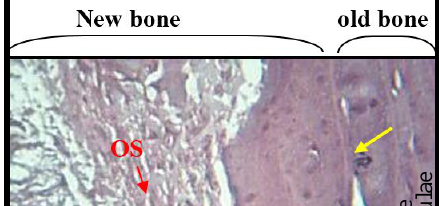
Figure 6: Microscopic view of coated implant after 6 weeks. Lamellae (Osteon formation) (yellow arrow). Haversian canal (black arrow). Osteoblasts (OB). Osteocytes (OS). H & E ×